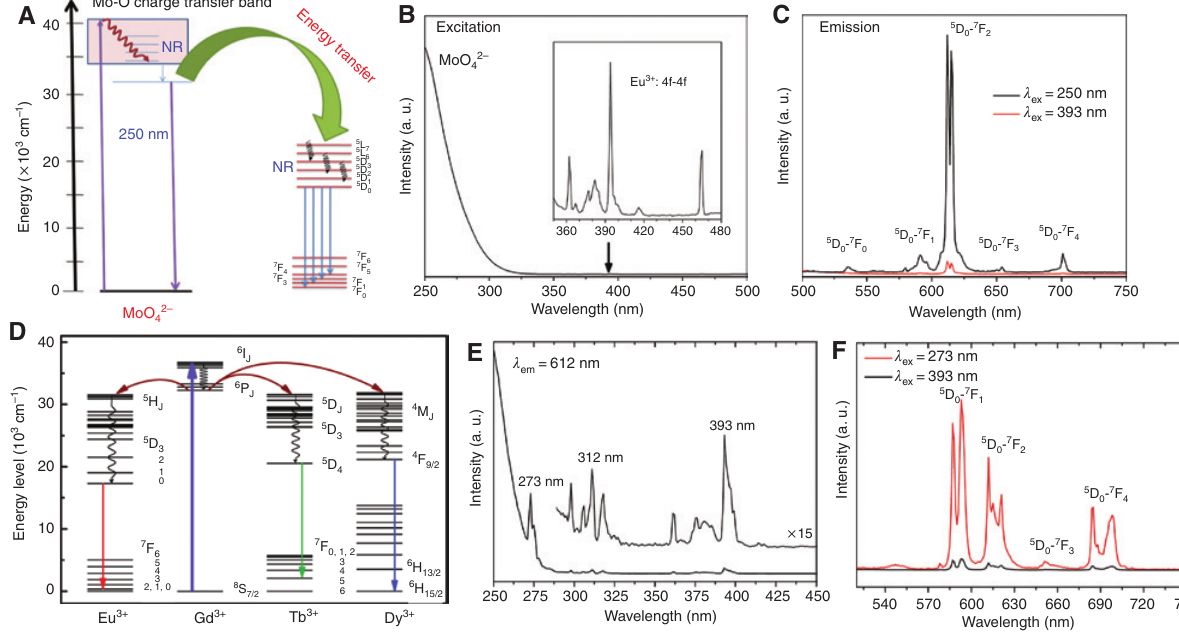
Figure 4: (A) ET mechanism between the MoO 42− and Eu 3 + energy levels. (NR = non-radiative) Taken from [204]. Reproduced with permission of The Royal Society of Chemistry. Copyright © 2015. (B) Excitation and (C) emission spectra of Eu 3 + -doped NaGd(MoO [89]. Published by The Royal Society of Chemistry. (D) Schematic energy levels of Ln 3 + ions describing the sensitized luminescence of Eu 3 + , Tb 3 + and Dy 3 + ions from Gd 3 + . The curly arrows denote multiphonon NR transitions, and the straight ones denote radiative transitions. Taken from [111]. Reproduced with permission of the American Chemical Society. Copyright © 2012. (E) Excitation and (F) emission spectra of Eu 3 + - doped GdPO NPs. Taken from [205]. Reproduced with permission of the American Chemical Society. Copyright © 4